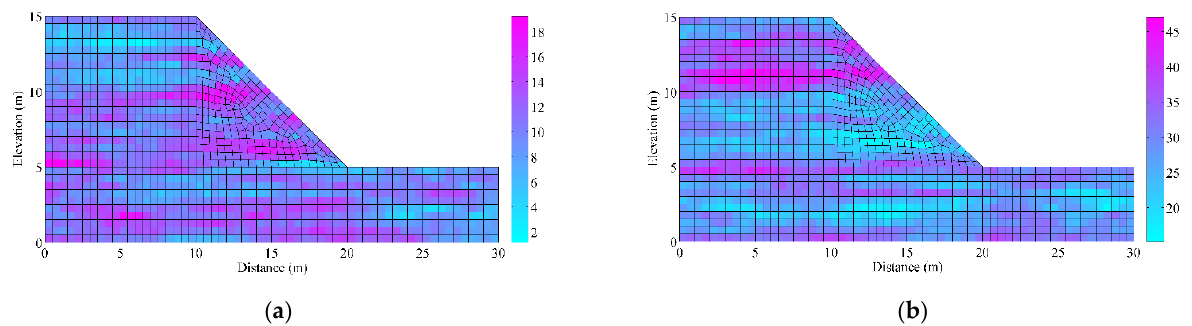
Figure 10. A typical realization of CCRF associated with TN margins. ( a ) Random field of c . ( b ) Random field of φ .